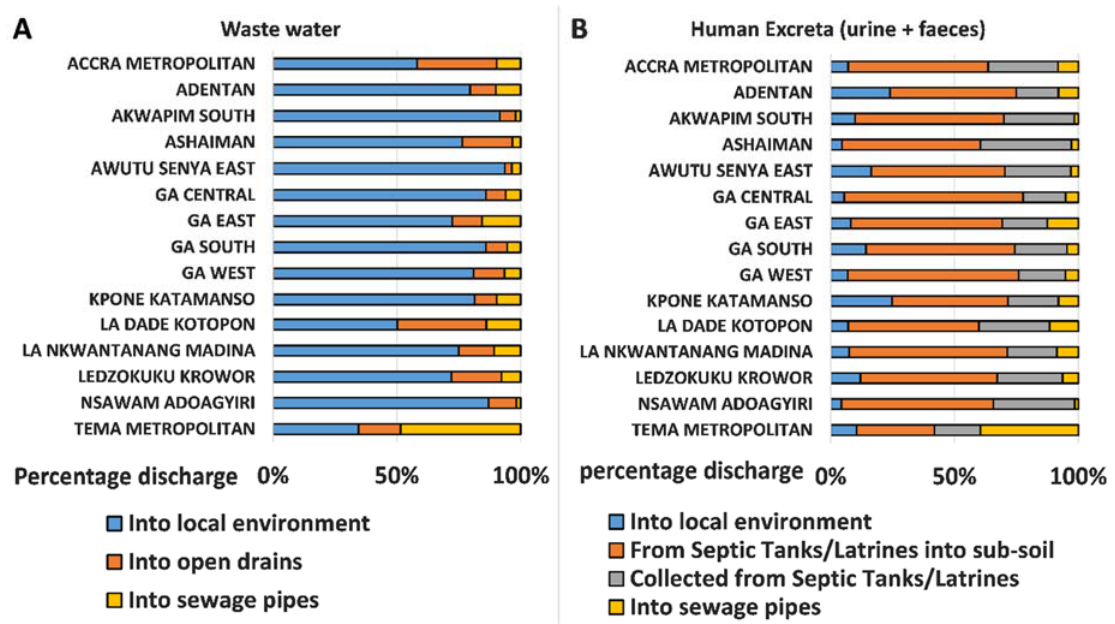
Figure 9. Proportion of wastewater and human excreta ending up in the environment and collected via sewage pipes and cesspit-tankers. ( A ) Share of wastewater per GAMA district discarded into the local environment, open drains or sewage pipes. ( B ) Share of human excreta (urine and faeces) per GAMA district disposed into the local environment, flown into sewage pipes, collected from septic tanks and pit latrines by tanker trucks, and leaked from septic tanks and pit latrines into the sub-soil.